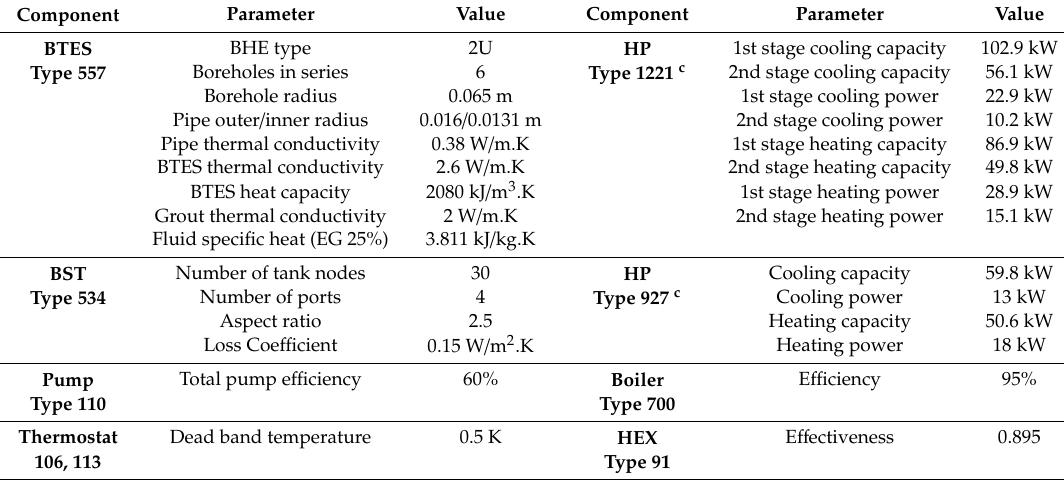
Table 5. Main TRNSYS parameters.